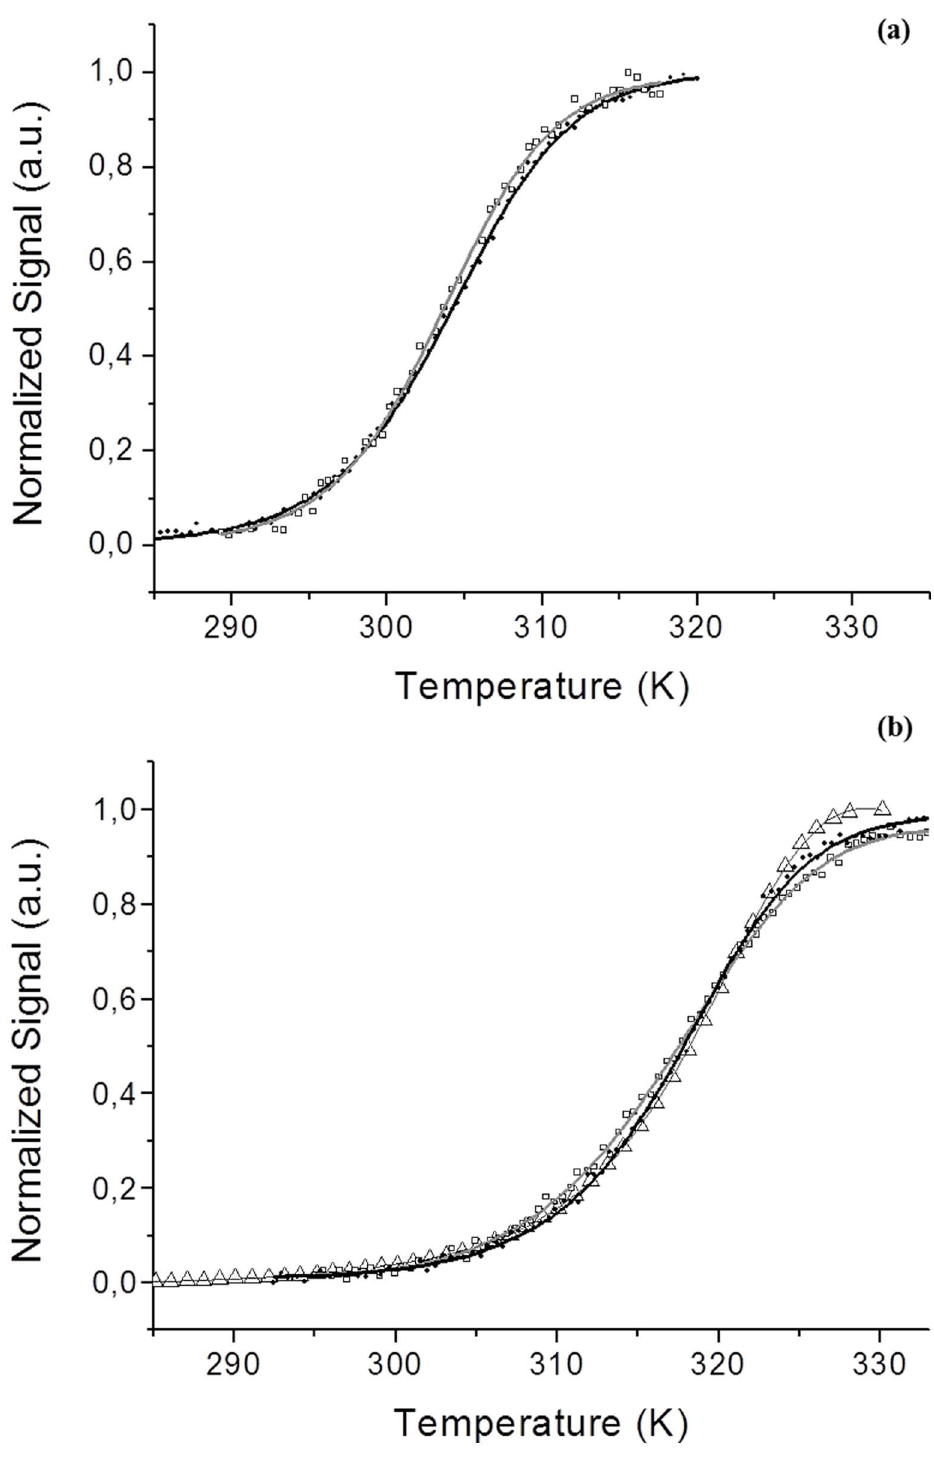
Fig 3. Thermal unfolding curves monitored spectroscopically in 150 mM NaCl, 100 mM MES pH 6.5. (a) (80 μ M) holo Sp Fld by Fluorescence(open triangles, gray line), far-UV CD (black circles, black line) and near-UV CD (open squares, gray line). (b) (80 μ M) apo Sp Fld by far-UV CD (black circles, black line) and near-UV CD (open squares, gray